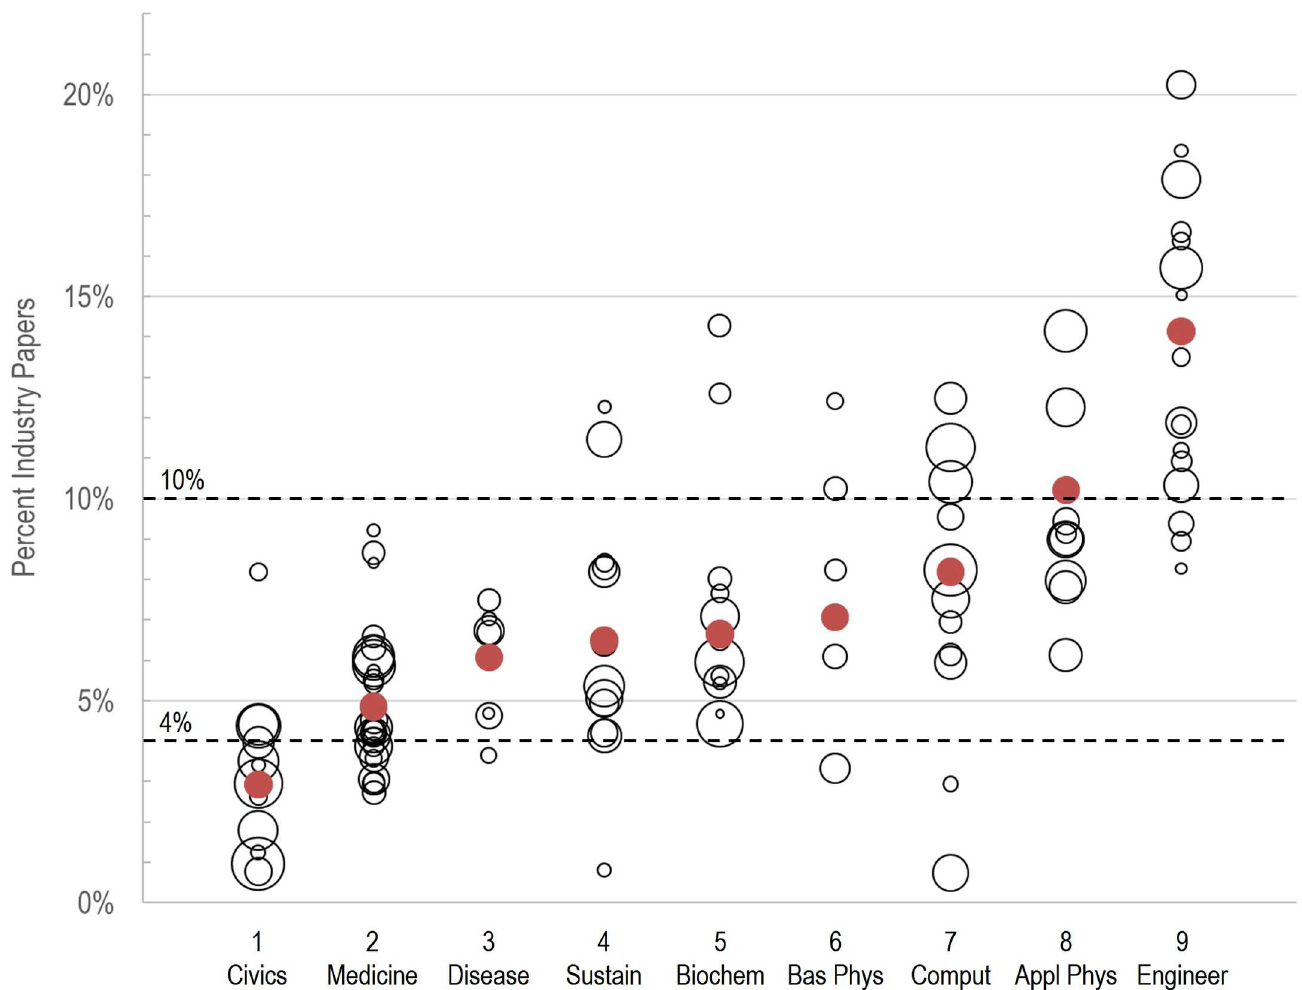
Fig 5. Industry involvement in 114 DC2 disciplines assigned to nine fields of research. Each disciplineis represented by its number as listed in S2 Table. Circle sizes reflect disciplinesizes whilefilled circles indicateaverageindustry authorship by field.